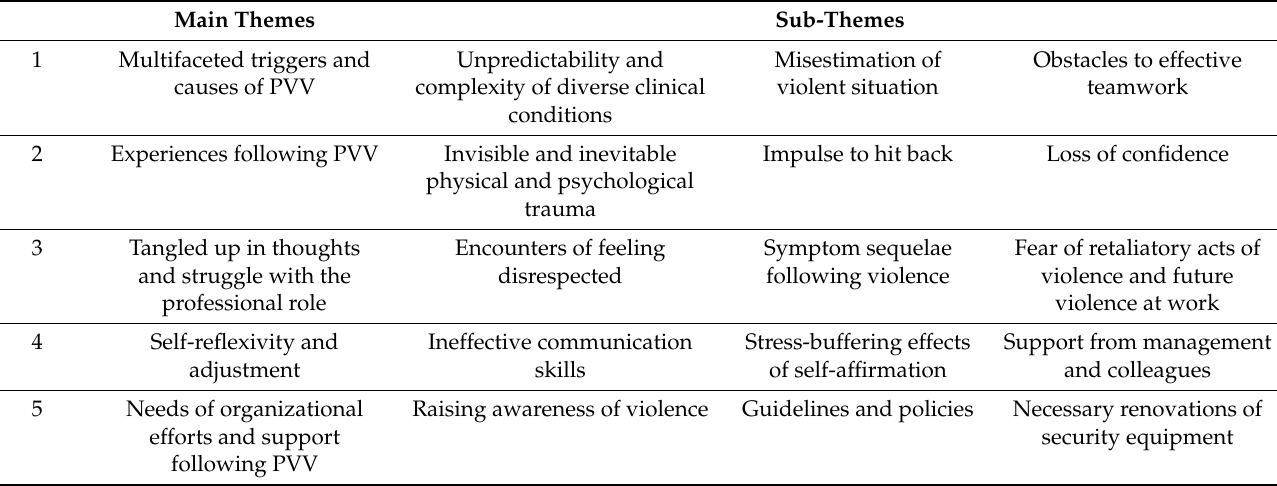
Table 1. Overview of themes and